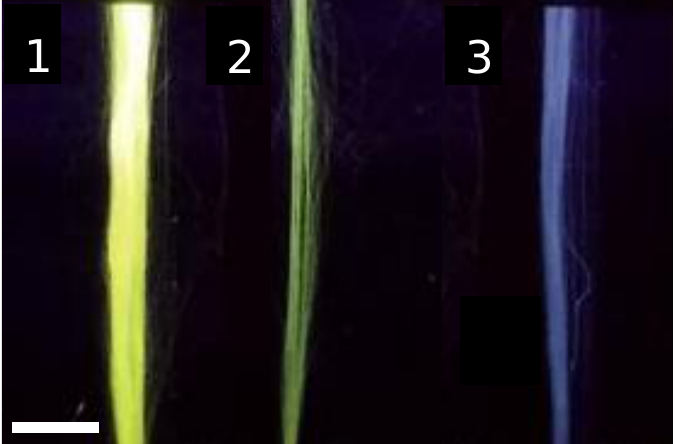
Figure 1. Illustrative fluorescence micrographs of SFS regenerated fibers illuminated with λ = 254 nm UV light ( 1 ) Yarn of fibers functionalized following Protocol A (Functionalization of the protein in solution and subsequent spinning), ( 2 ) yarn of fibers functionalized following Protocol B (Immersion of the fibers in an FITC solution), and ( 3 ) yarn of control (non-functionalized) fibers. The scale bar corresponds to 5 mm.